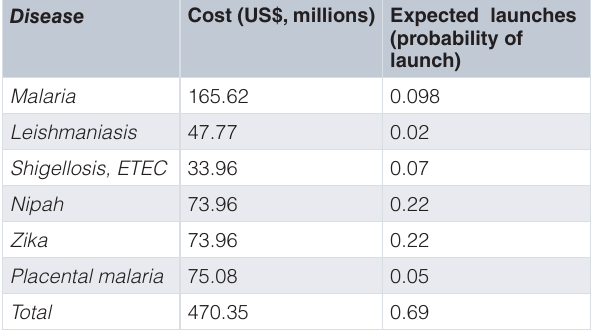
Table 5. Cost and launch probability per disease based on P2I v.2 model projections. Disease Cost (US$, millions) Expected launches